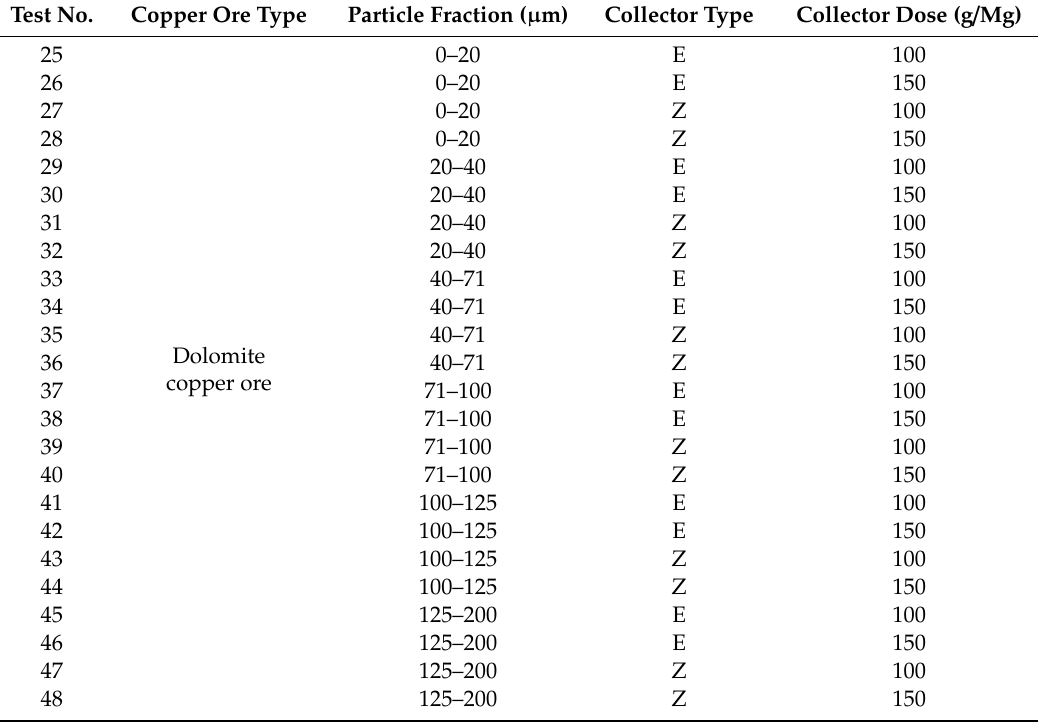
Table 4. The variability range of parameters of the flotation test planned and carried out according to the experimental plan (E—aqueous solution of ethyl sodium xanthate; Z—aqueous solution of isobutyl sodium xanthate)—Denver machine, dolomite copper ore. Test